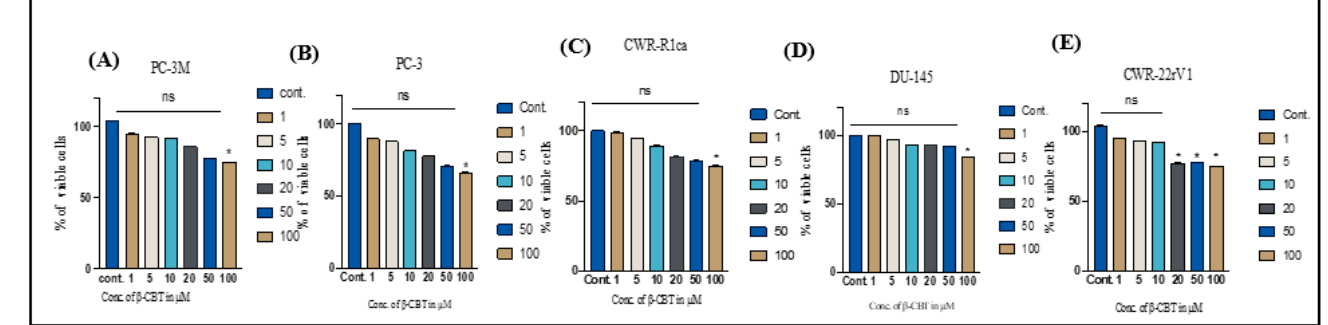
Figure 1. The effects of β -CBT on the viability of a human PC cell lines panel. Bar graphs represent the percent cell viability in vehicle, 1, 5, 10, 20, 50, and 100 μ M of β -CBT-treated PC cells. Figures represent treatments to PC-3M ( A ), PC-3 ( B ), CWR-R1ca ( C ), DU-145 ( D ), and CWR-22rv1 ( E ) cells. “ns” indicates statistical non-significance at p < 0.05. * indicate statistical significance relative to control cells at p < 0.05.